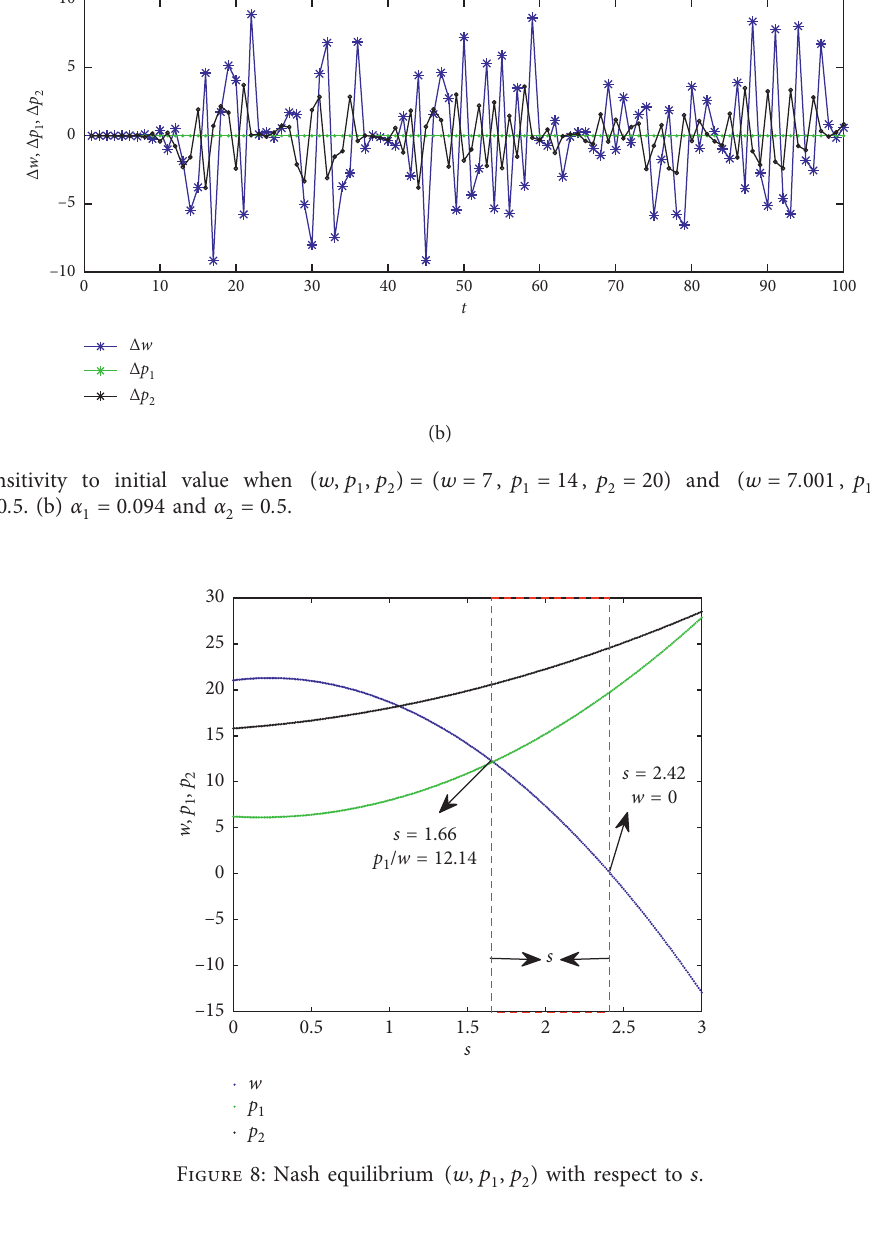
, p ) with respect to s . 1 2